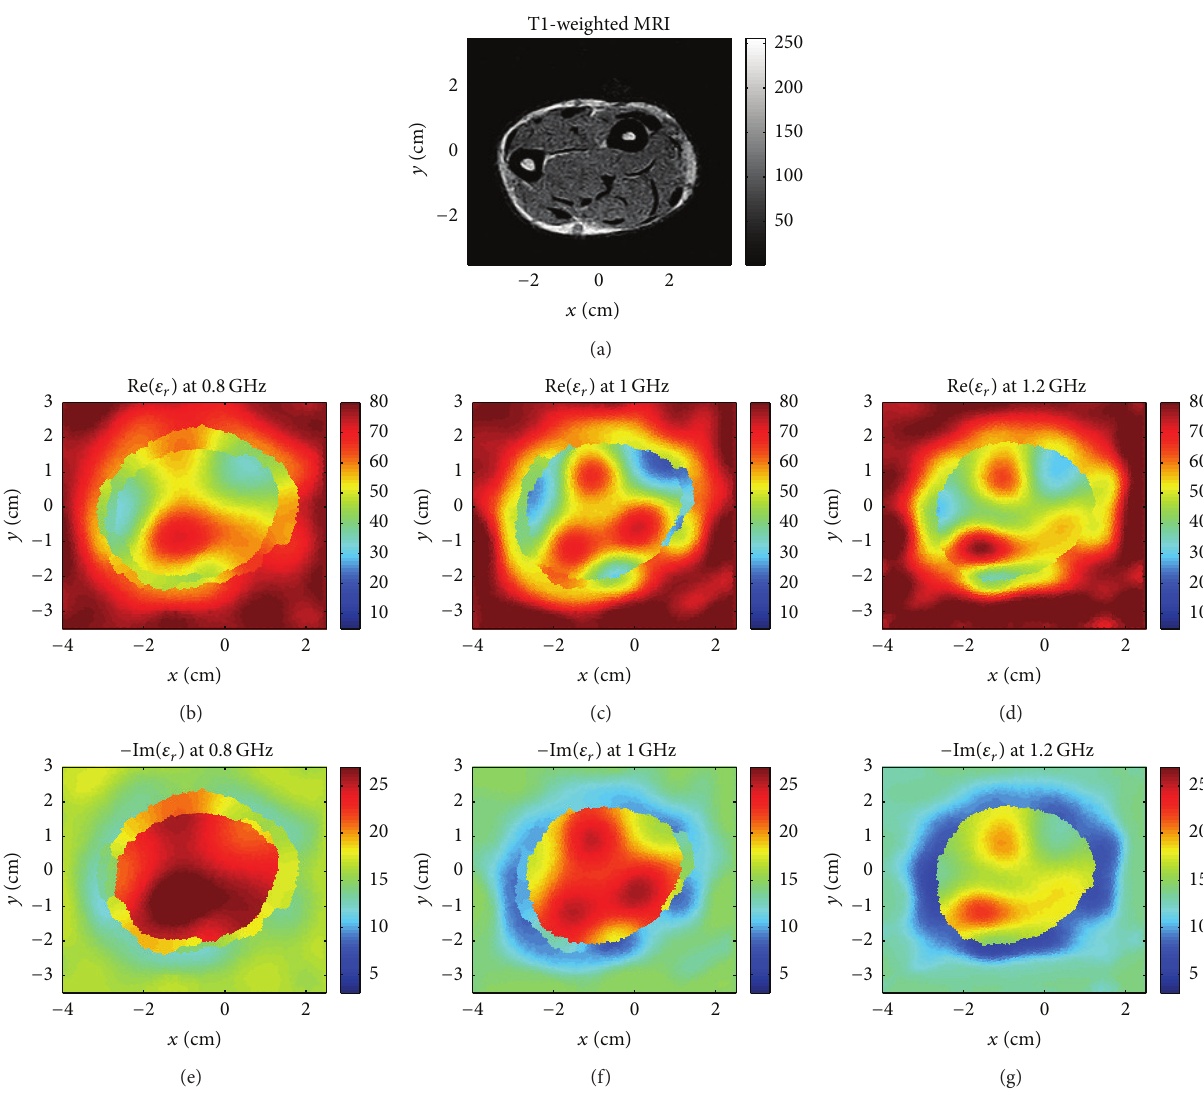
Figure 8: Volunteer 5: (a) the T1-weighted MRI image. MWI reconstructions of the relative complex permittivity real and imaginary compo- nents at (b), (e) 0.8 GHz, (c), (f) 1GHz, and (d), (g) 1.2GHz.